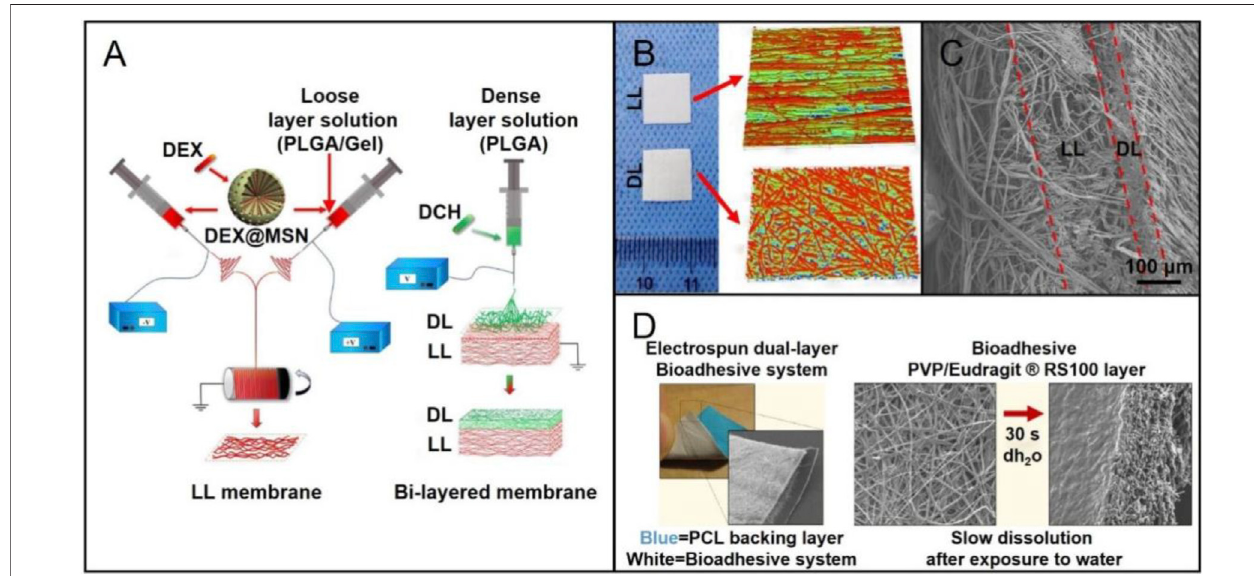
FIGURE 3 | (A) Schematic diagram showing the preparation of a bi-layered GBR membrane: fabrication of the PLGA/gelatin nano fi brous membrane (loose layer) using the conjugated electrospinning method with a customized rotating collector (left) ; deposition of the PLGA nano fi bers (dense layer) on the loose layer by the traditionalelectrospinningtoformthebi-layeredGBRmembrane (right) .Reproducedwithpermission(Lianetal.,2019).Copyright2019,Elsevier. (B) Macroscopicand surface topography appearances of the dense layer (DL) and loose layer (LL). Reproduced with permission (Lian et al., 2019). Copyright 2019, Elsevier. (C) Cross- sectional SEM image of the bi-layered membrane. Reproduced with permission (Lian et al., 2019). Copyright 2019, Elsevier. (D) Photograph of the dual-layer bioadhesivesystem,andtheSEMimageshowingthePCL fi bersinthebackinglayer (left) .SEMimagesofthebioadhesivelayermadeofablendofpoly(vinylpyrrolidone) (PVP) and Eudragit RS100 (RS100) before and after dissolved in water. Reproduced with permission (Santocildes-Romero et al., 2017). Copyright 2017, American Chemical